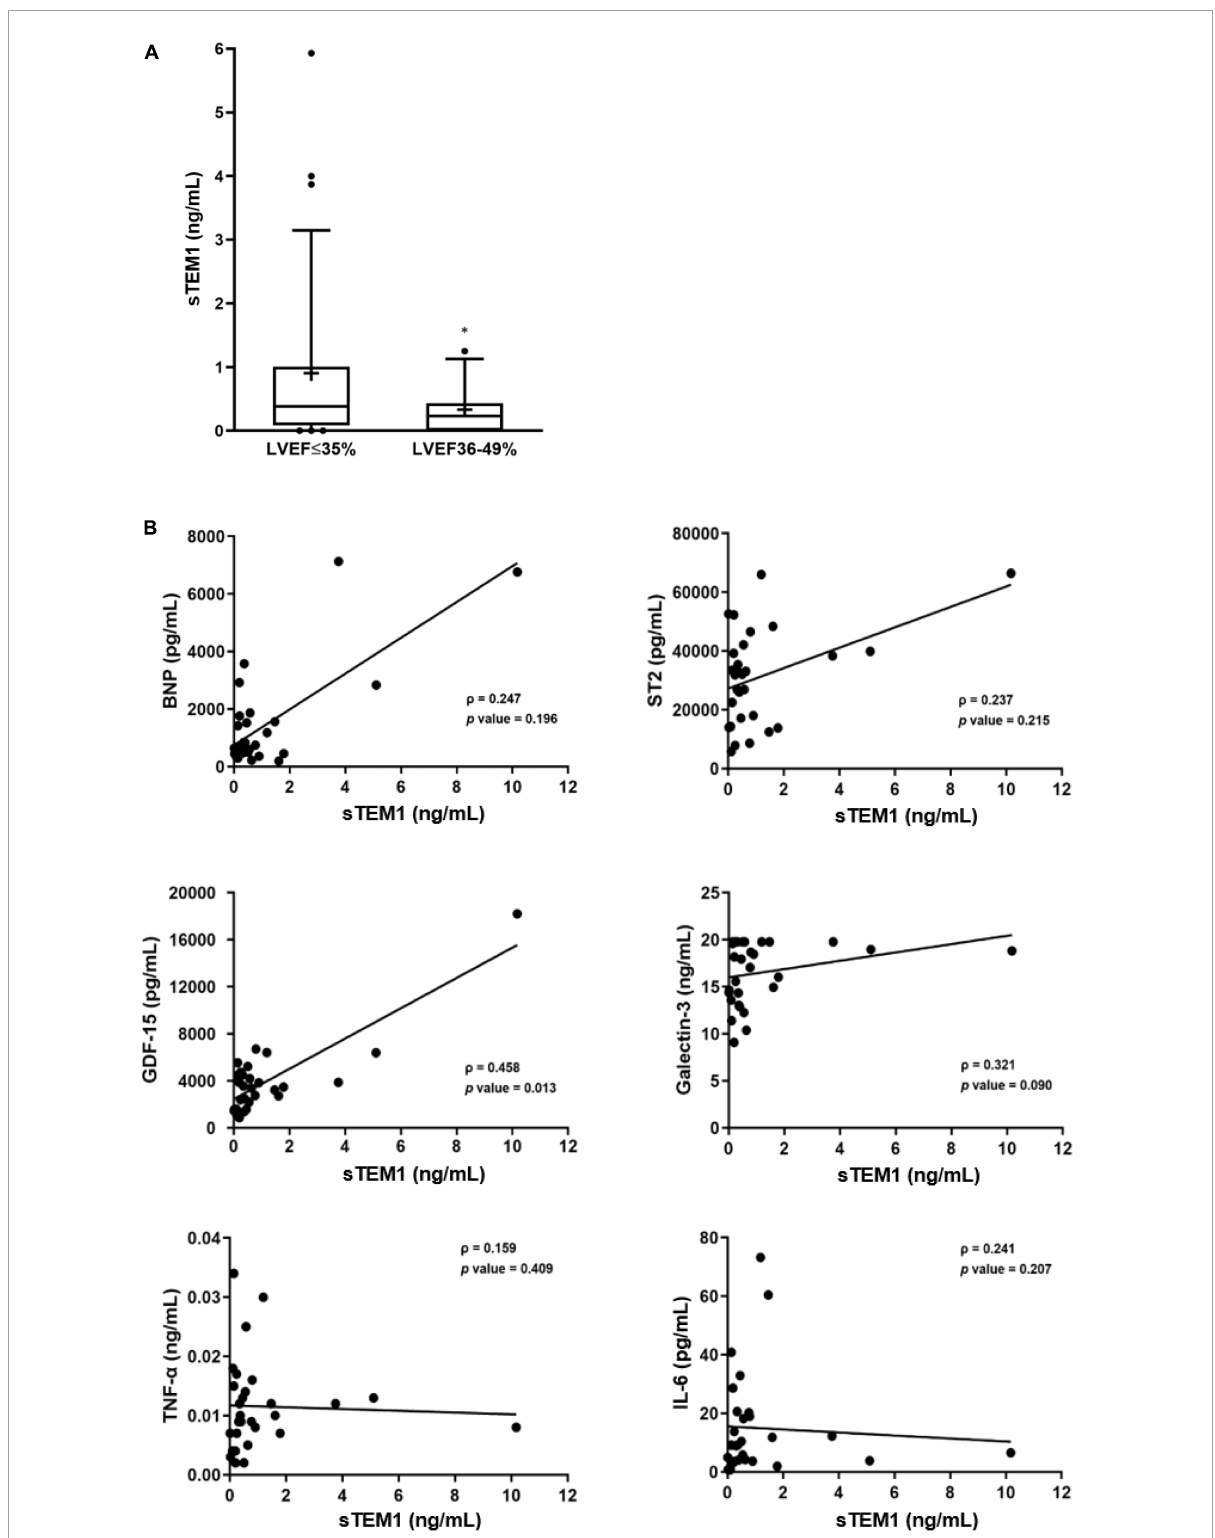
FIGURE2 Soluble TEM1 in human heart failure. (A) Higher levels of sTEM1 in heart failure with severely depressed left ventricular ejection fraction ∗ p < 0.05. (B) Correlations of sTEM1 with biomarkers of heart failure and inflammation in patients with heart failure. BNP, B-type natriuretic peptide; GDF, growth differentiation factor; ST2, suppression of tumorigenicity 2; TNF- α , tumor necrosis factor- α ; IL-6,